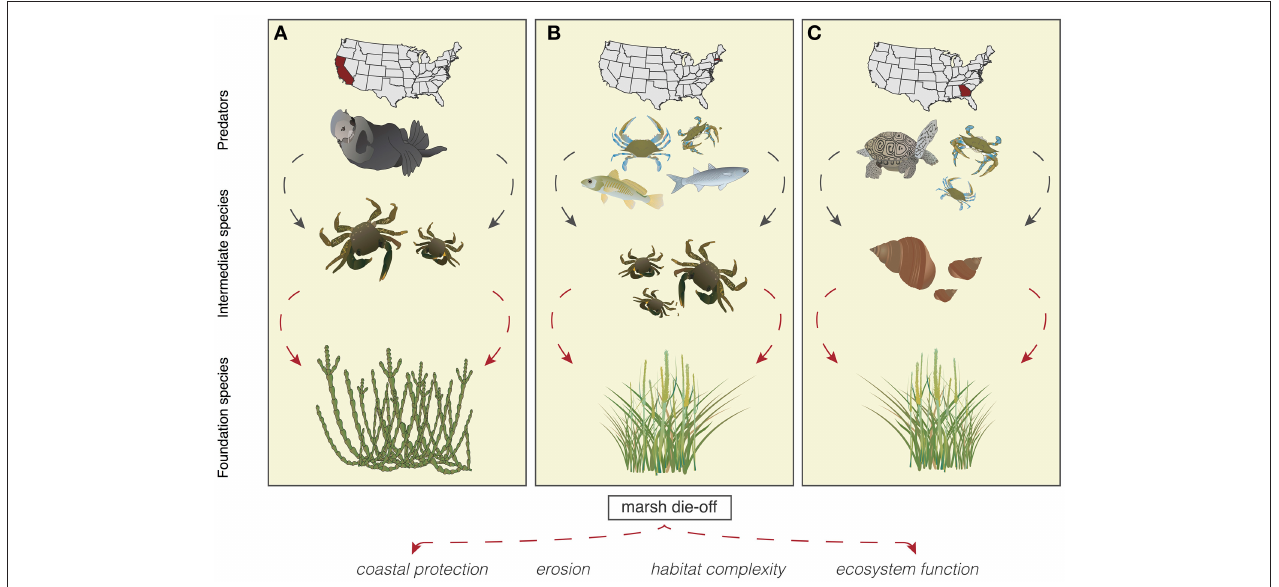
FIGURE 3 | Demonstrated trophic cascades in United States salt marshes. (A) In the western U.S. sea otters control herbivorous crabs, which can cause erosion and loss of salt marshes (Hughes et al., in personal communication). (B) In New England Blue crabs control herbivorous crabs, which can cause runaway grazing on cordgrasses ( Altieri et al., 2012). (C) In the Southeast U.S. blue crabs and terrapins control periwinkle snails, which graze on marsh grasses (Silliman and Bertness, 2002 ). See acknowledgments for vector